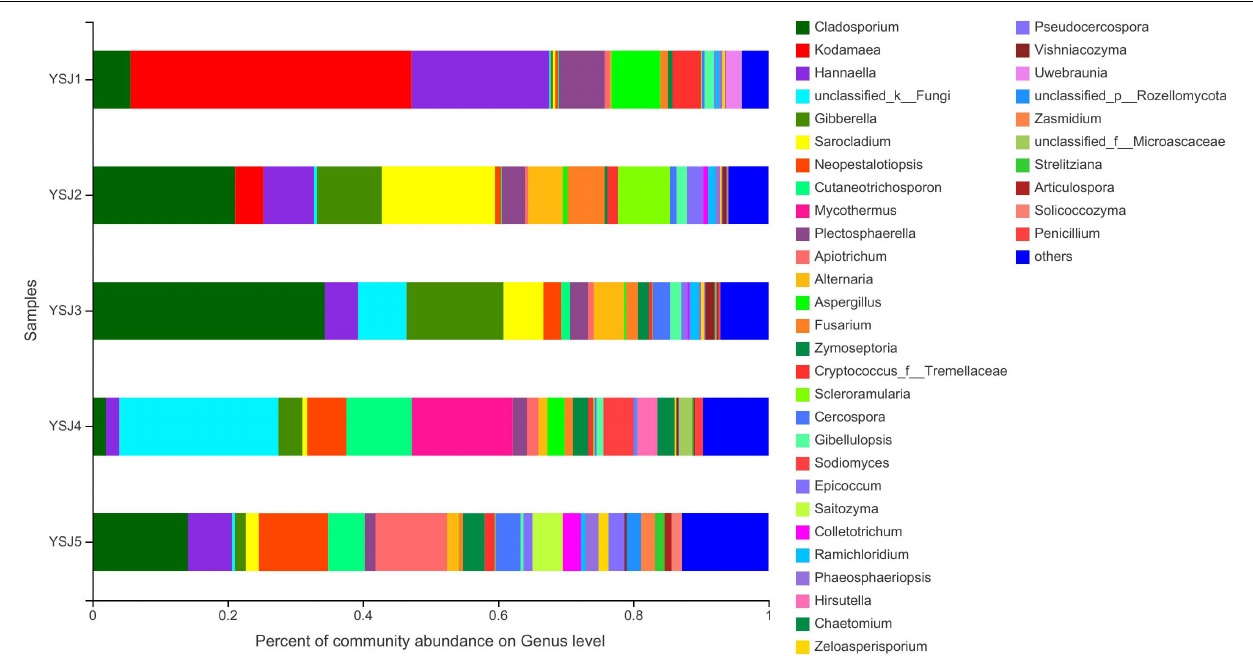
FIGURE 3 | Fungal community structure bar plot analysis at the genus level. The ordinate represents sample name, and the abscissa represents the percentage of different species, which is represented by columns with different colors, sizes, and proportions of a species.